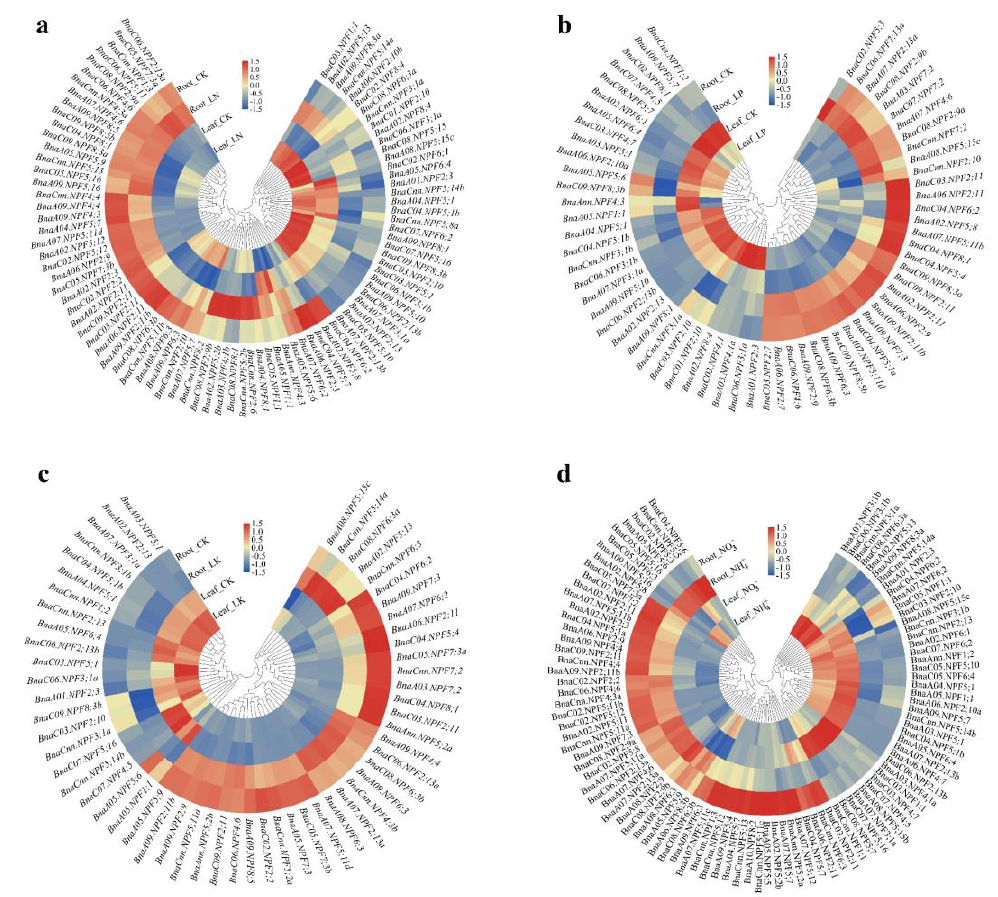
Figure 5. Expression profiles of the NPF family differentially expressed genes (DEGs) in the leaves and roots of Brassica napus under nitrogen (N), phosphorus (P), potassium (K) stress ( a – c ) and ammonium toxicity ( d ) environments. For nutrient stress treatments, 14-day-old seedlings were exposed to N, P and K for seven days. For ammonium toxicity assay, 14-day-old seedlings were treated with 6 mM NO 3- (control) and NH 4+ only for nine days. The fully expanded leaves and roots were sampled separately for RNA-seq analysis. CK, normal nutrient supply. LN, N deficiency. LP, P deficiency. LK, K deficiency. NO 3- , NaNO 3 . NH 4+ , NH 4 Cl. The color scale is shown in the middle. Heat maps of gene expression profiles were generated using TBtools after data normalization (Z-score).